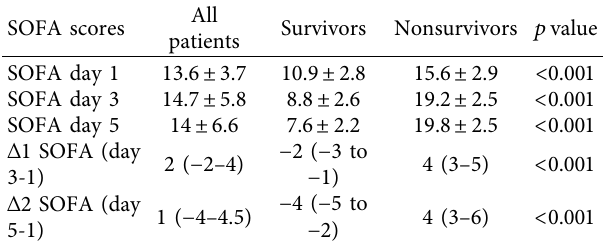
Table 5: SOFA scoring of studied VA-ECMO